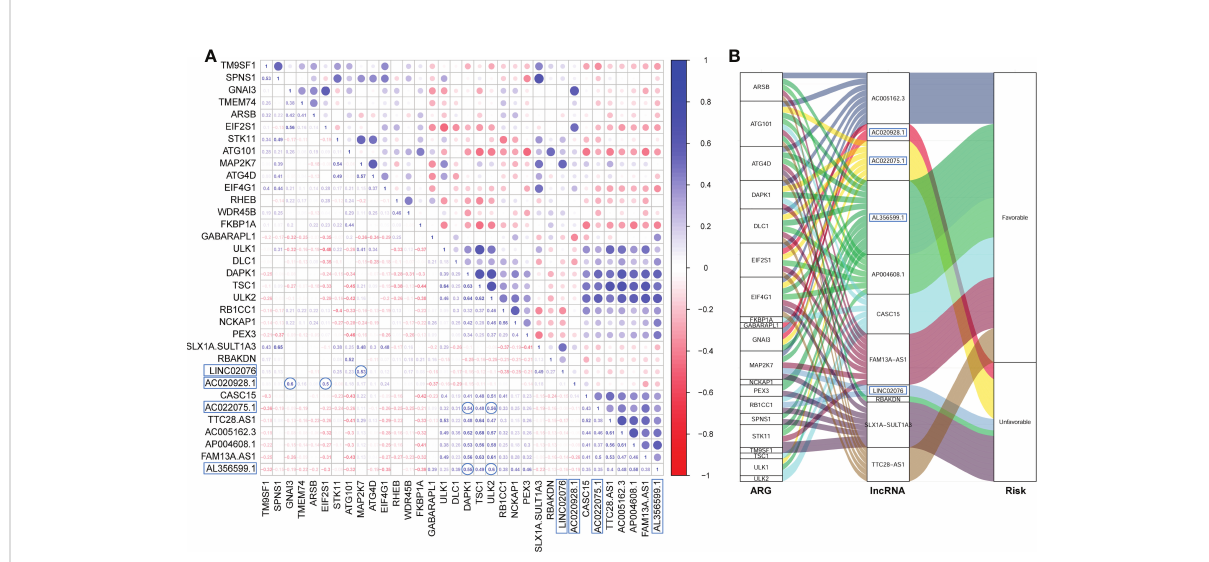
FIGURE 2 The Pearson correlation among the ARGs and lncRNAs. (A) The Pearson correlation matrix. (B) The alluvial plot represents the correlation between the ARGs and the lncRNAs (Pearson correlation threshold ≥ 0.5). ARG, autophagy-related gene; lncRNA, long noncoding RNA.